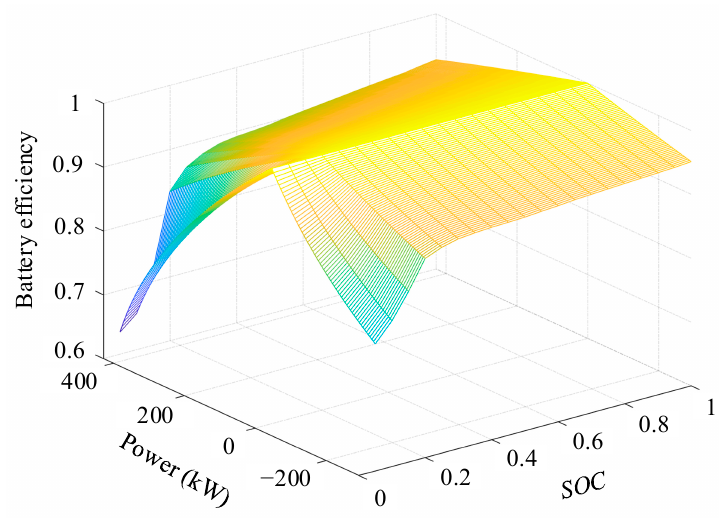
Figure 5. Battery efficiency map.